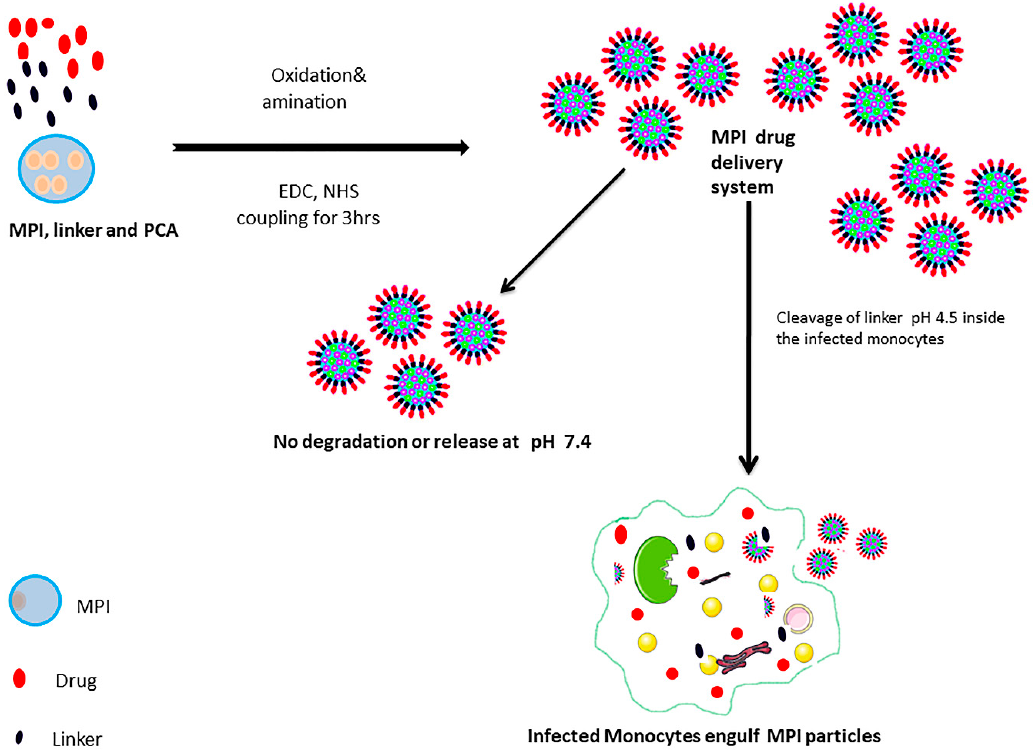
Figure 1. Schematic illustration of the MPI drug delivery system.